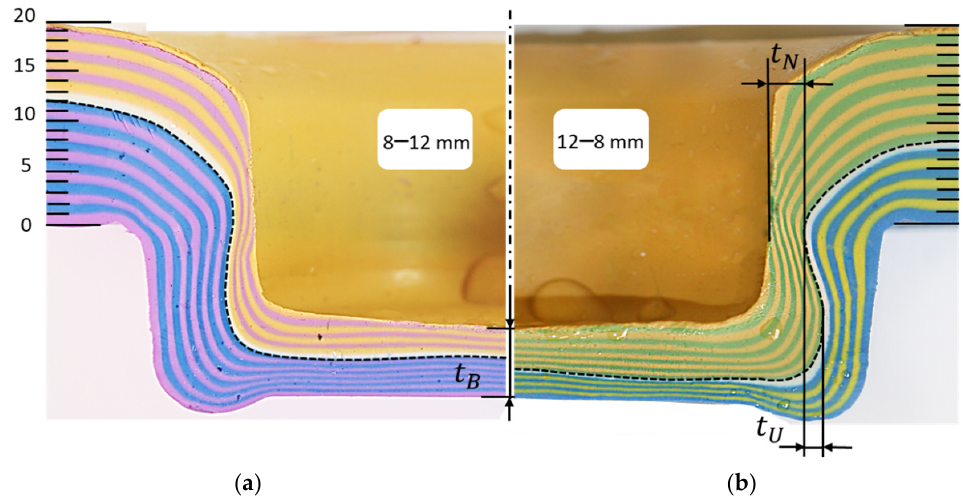
Figure 8. Comparing the final shape of experiments: ( a ) left; inverted combination (S1: 8–12 mm) and ( b ) right; base model (S4: 12–8 mm) in single stroke clinching of plasticine. Table 2. Interlock of each layer in experiments S4 (12–8) and S1 (8–12). Layer